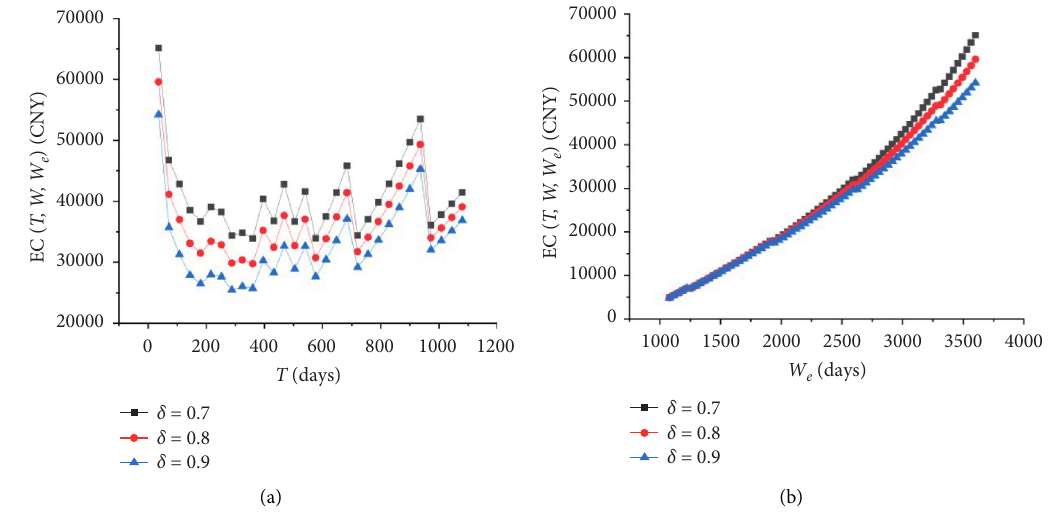
Figure 9: EW cost change with improvement factor δ when W